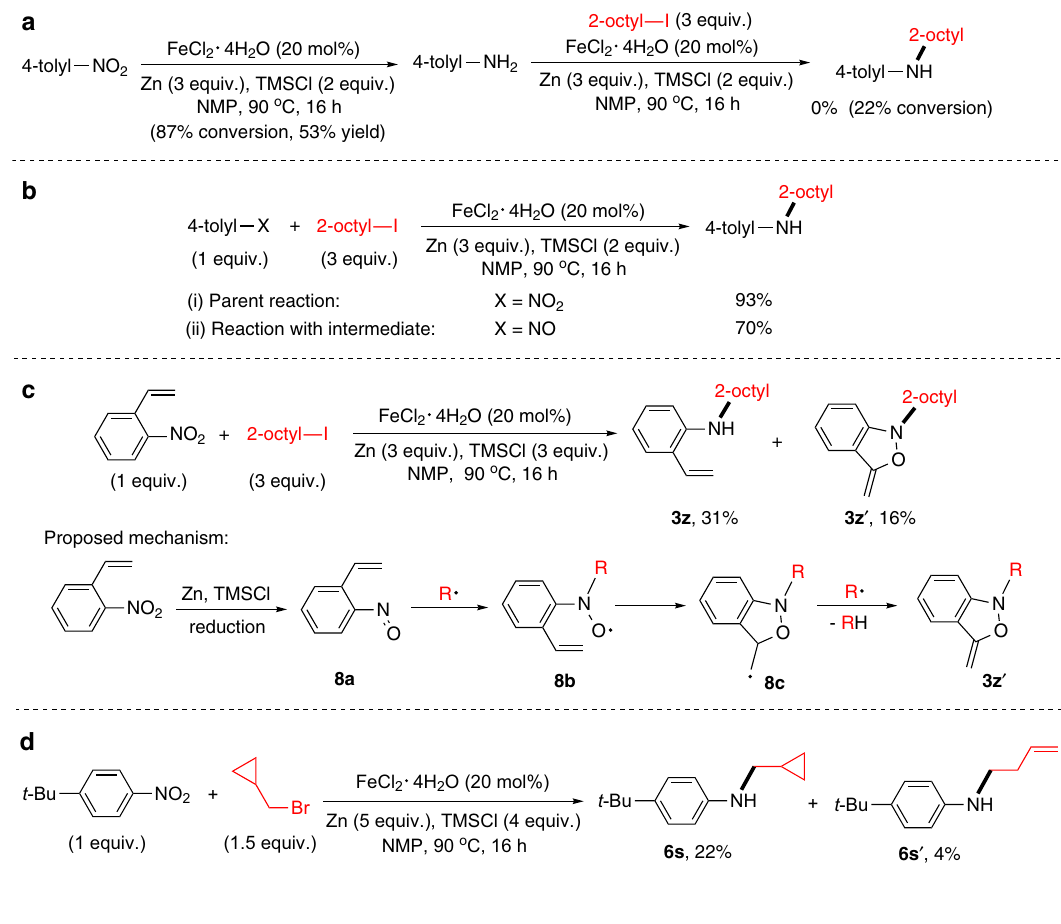
Nature Communications 7:12494 doi: 10.1038/ncomms12494 (2016); Published 12 Aug 2016; Updated 6 Dec 2016